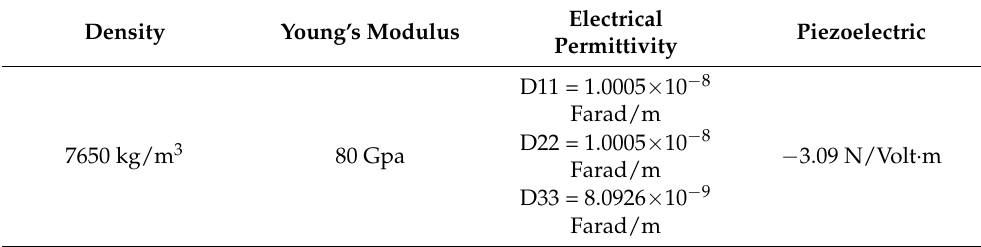
Table 3. The material properties of PZT.